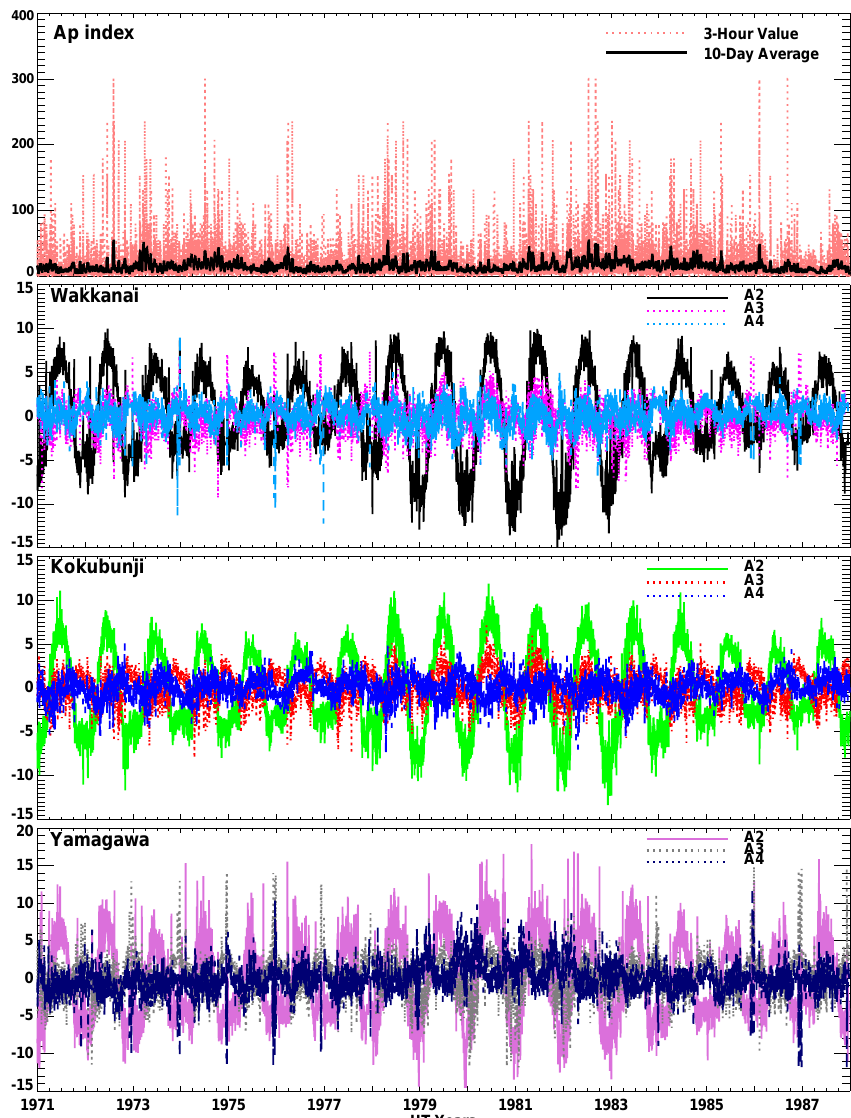
Fig. 4. Long-term variation of Ap index and the 2nd to 4th EOF coefficients from